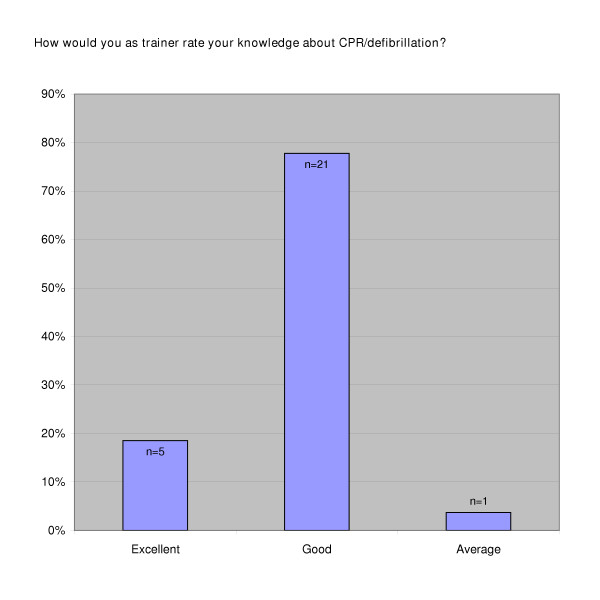
How would you as trainer rate your knowledge about CPR/defibrillation?. Students as trainers in a CPR course for Cardiac Arrest Survivors were asked about their knowledge about the topics of CPR and defibrillation after the course. Excellent – My knowledge about CPR and defibrillation is excellent compared to other students. Good – My knowledge about CPR and defibrillation is good compared to other students. Average – My knowledge about CPR and defibrillation is average compared to other students.